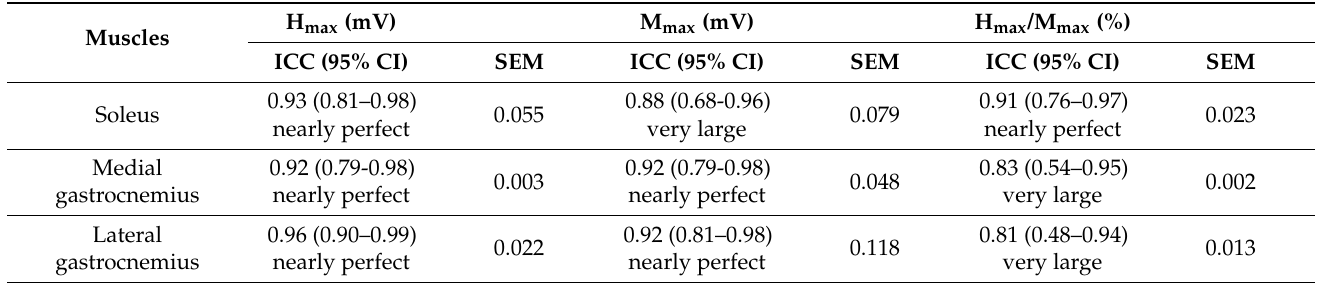
Table 2. Inter-day reliability of the H max , M max , and H max /M max in pre-KT conditions.